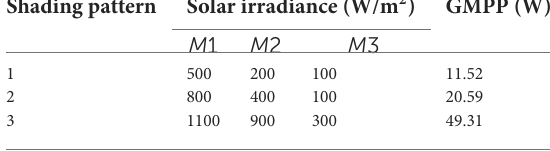
TABLE 2 Partial shading patterns for the step test. Shading